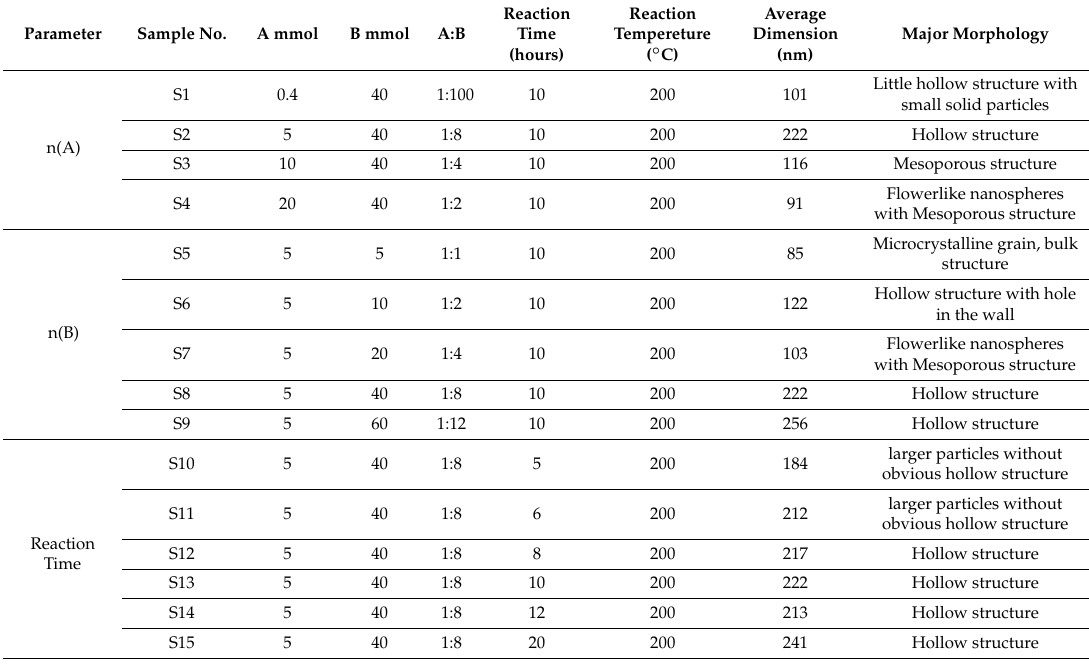
Table 1. The major morphology of samples obtained in specific experimental condition, A: FeCl 3 · 6H 2 O, B: